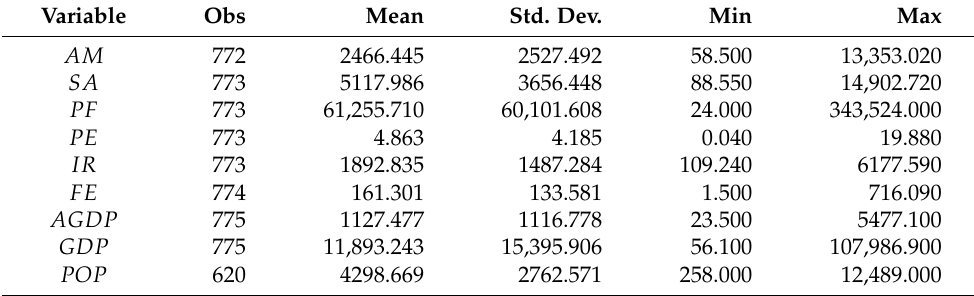
Table 2. Data description.